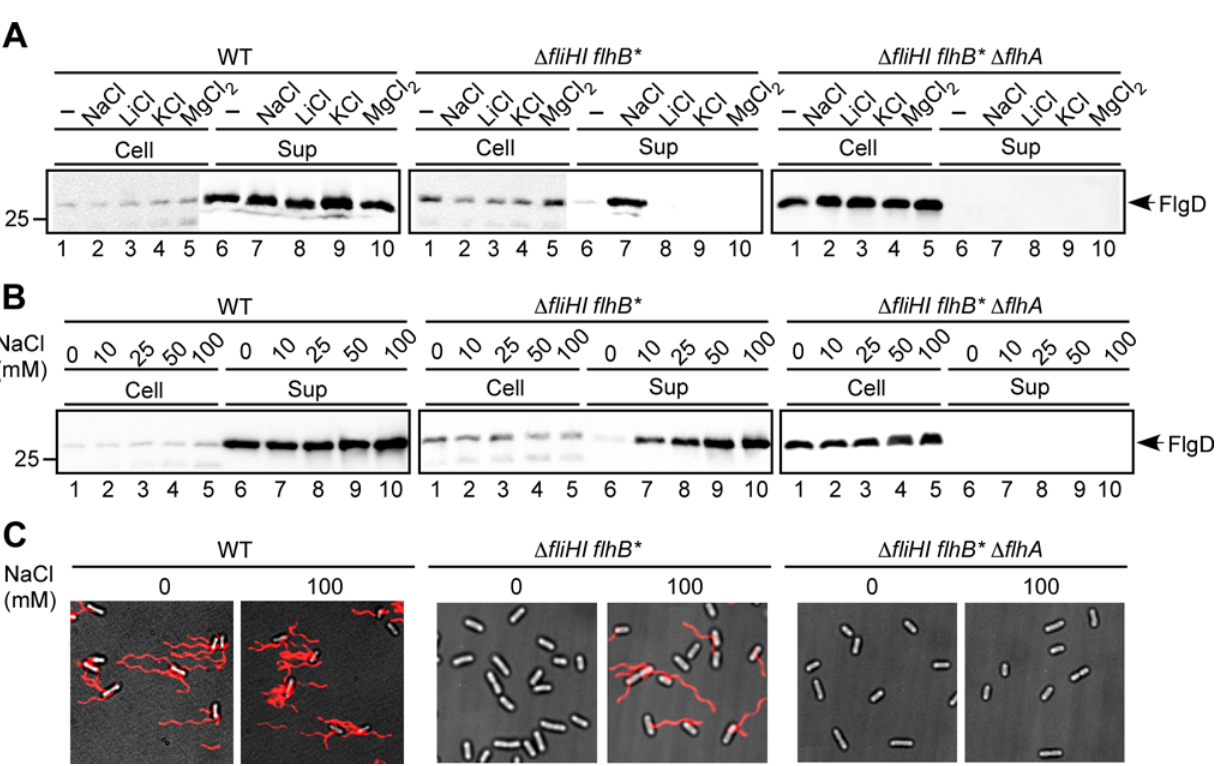
Fig 1. Effect of Na + on flagellar protein export by the Salmonella wild-type (left panels), Δ fliH-fliI flhB(P28T) bypass mutant (middle panels) and Δ fliH-fliI flhB(P28T) Δ flhA mutant cells (right panels). (A) Effect of various cations on protein export at external pH 7.5. Immunoblotting, using polyclonal anti-FlgD antibody, of whole cell proteins (Cell) and culture supernatant fractions (Sup) prepared from SJW1103 (WT), MMHI0117 ( Δ fliHI flhB * ) and NH004 ( Δ fliHI flhB * Δ flhA ) grown exponentially at 30°C in T-broth containing 100 mM NaCl, 100 mM LiCl, 100 mM KCl or 100 mM MgCl 2 at an external pH of 7.5. (B) Effect of external NaCl concentrations on the secretion level of FlgD at external pH 7.5. (C) Effect of external NaCl concentrations on flagellar filament formation. The epi-fluorescence images of the filaments labeled with Alexa Fluor 594 (red) were merged with the bright field images of the cell bodies.